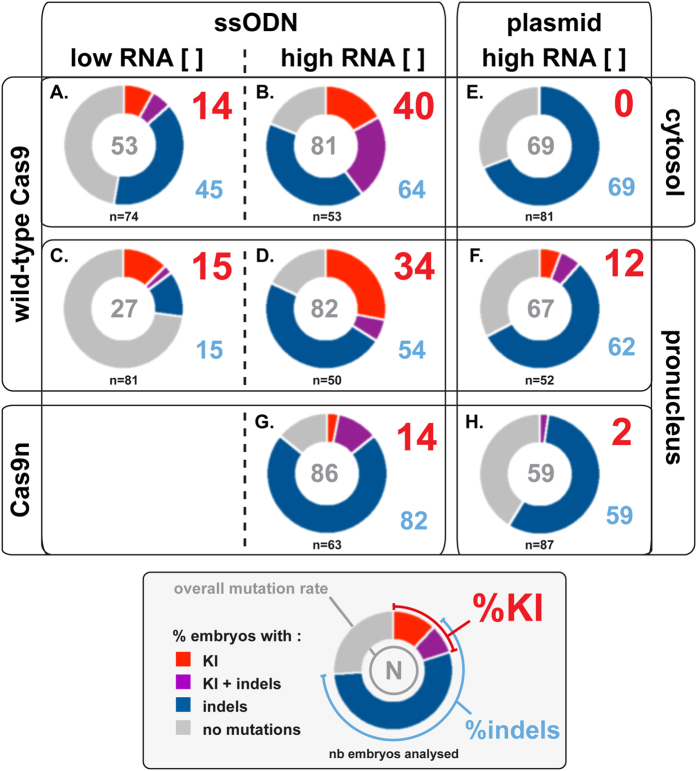
Comparison of the effect of several parameters on KI efficiency.Each circle represents the proportion of embryos with KI, indels, KI and indels, or wild-type only alleles for a given condition. The overall mutation rate, which corresponds to the proportion of embryos displaying at least one edited allele, is indicated at the center of each disk. Because some embryos contained both KI and indels alleles, the overall mutation rate can be less than the sum of the rates of KI and indels alleles. High concentration ([]) correspond to 100 ng/μl of Cas9 mRNA and 50 ng/μl of sgRNA while low [] corresponds to 5 ng/μl of Cas9 mRNA and 2.5 ng/μl of sgRNA. ssODN and circular plasmid were injected at 20 and 40 ng/μl respectively.